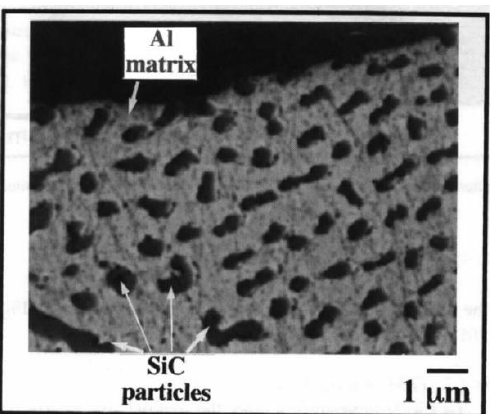
Figure 18. SEM micrograph of the cross-section of a selected ball milled SiC 10 /Al 90 particle following 43 ks milling.